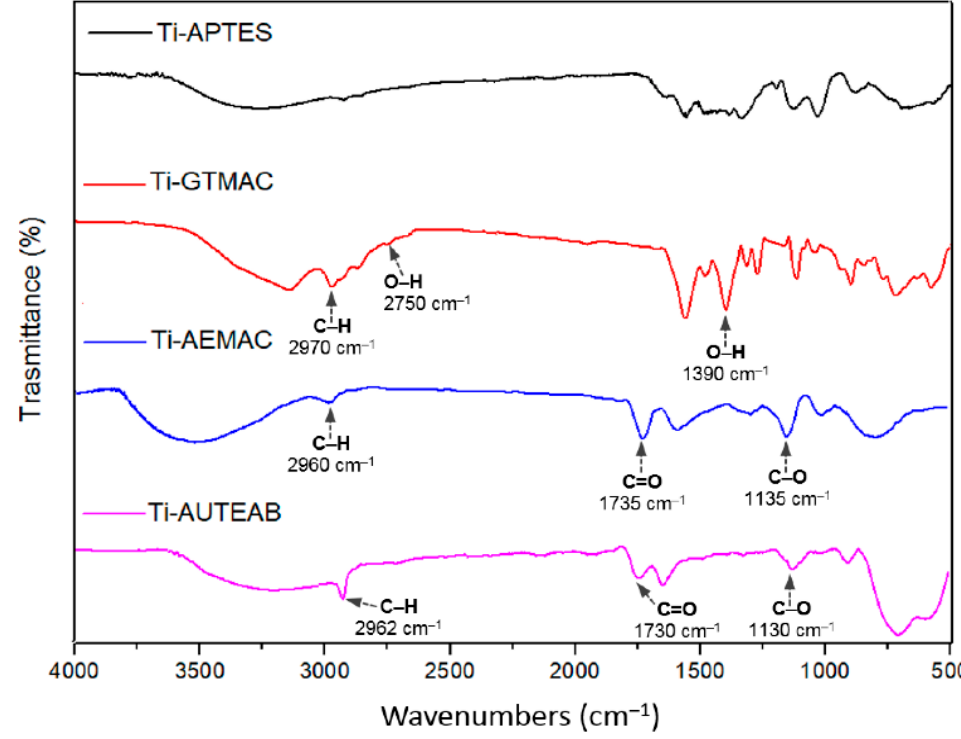
Figure 7. FTIR spectrum of Ti-AEMAC, Ti-GTMAC, and Ti-AUTEAB specimens, relevant with Ti-APTES specimens. Reprinted with permission from [68]. Copyright 2021 MDPI. Distributed under Creative Commons Attribution-based license (CCBY 4.0.).